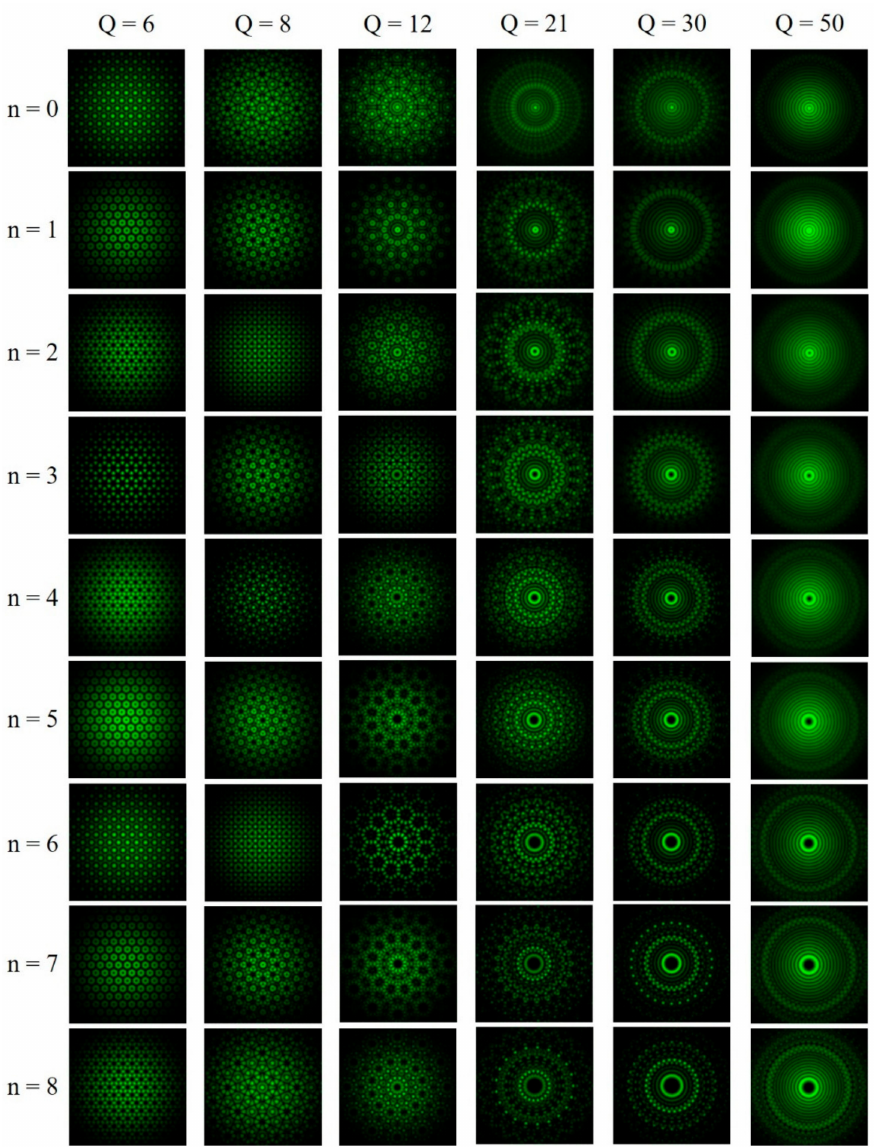
(cid:12) (cid:12) 2 with several values of n for Q = 6, 8, (cid:12) Φ Q ( ρ , φ ; θ n ) (cid:12)